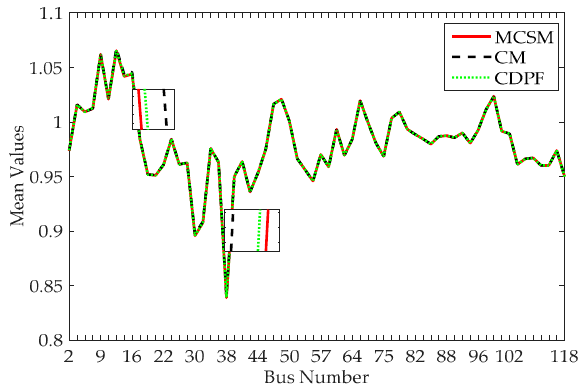
Figure 13. The means of the voltage magnitude at PQ buses in an IEEE 118-bus power system.